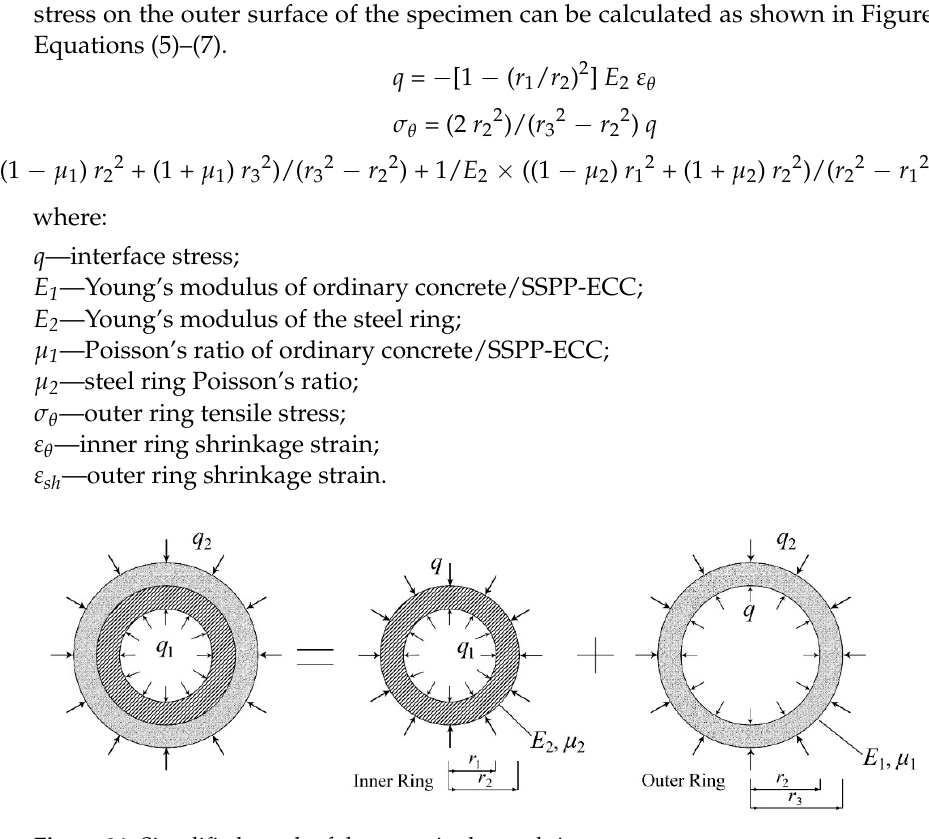
Figure 21. Simplified graph of the stress in the steel ring.